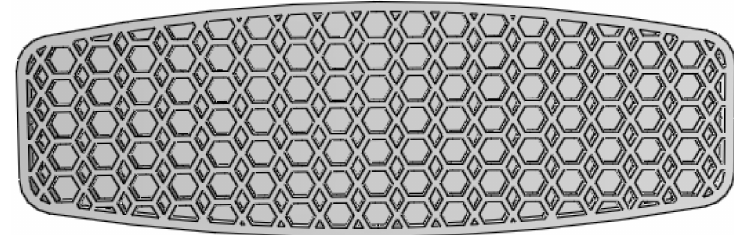
Figure 15. The bottom shell of the board with the hexagonal-rhombic